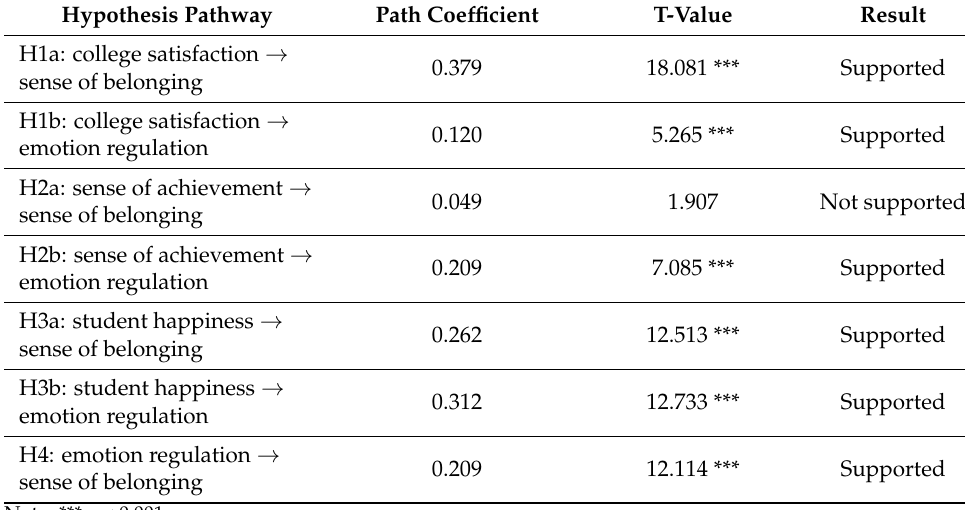
Table 3. Structural model